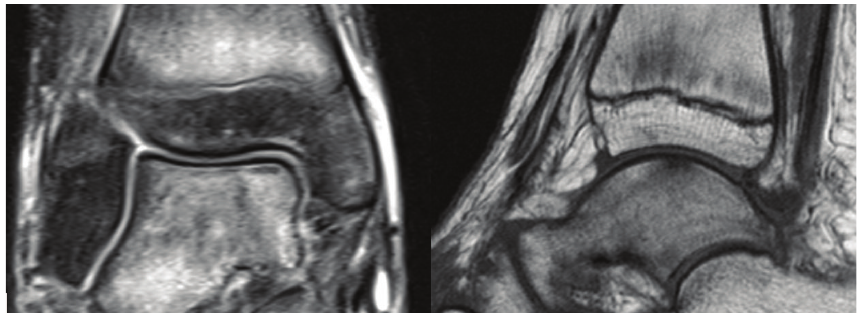
Figure 3: A coronal fat suppressed T2-weighted image and a sagittal T1-weighted image of a 12-year-old girl after ankle sprain showing diffuse bone marrow edema of the talus and the tibia. On conventional imaging, only subchondral bandlike osteoporosis of the talar dome could be seen (Figure 2).